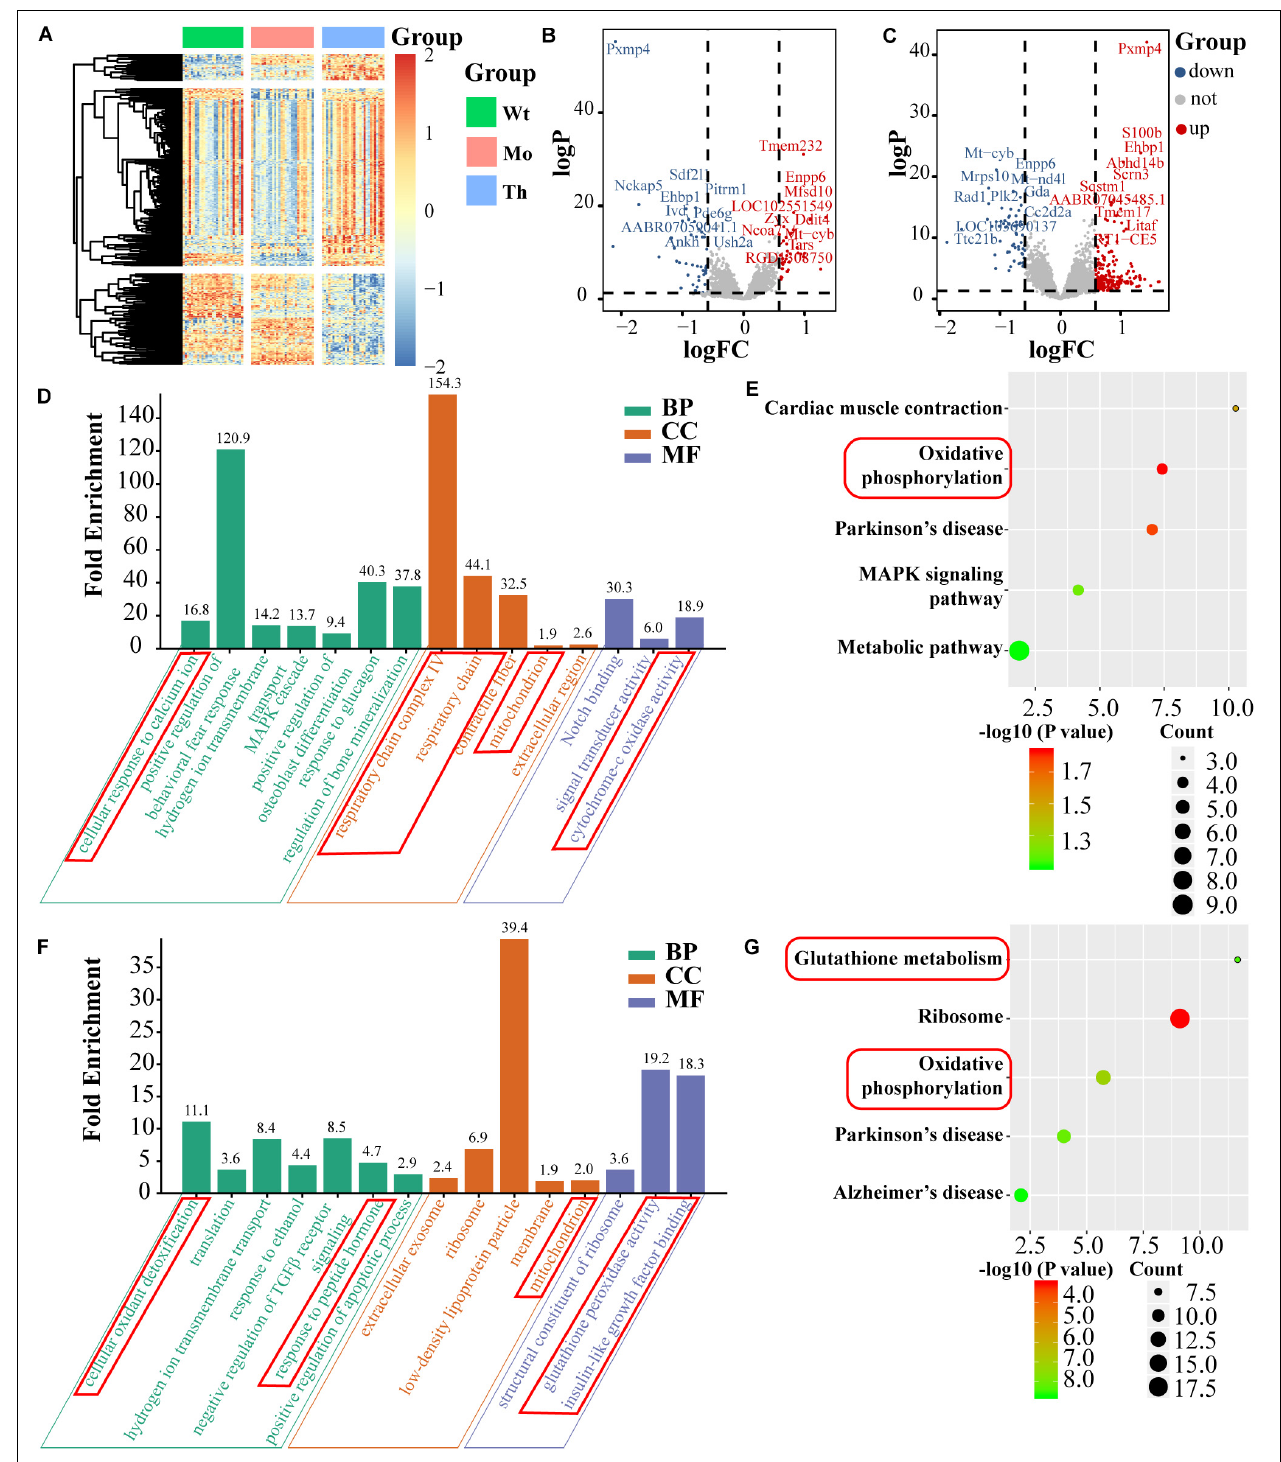
FIGURE 5 | Single-cell mRNA sequencing and bioinformatics analysis. (A) Heatmap of DEGs. (B,C) Volcano plots of DEGs (left panel for comparison between the Mo and Wt groups; right panel for comparison between the Th and Mo groups); the top 10 up-regulated and down-regulated DEGs were labeled with their names. BP, CC, and MF stand for biological process, cellular component and molecular function, respectively. (D,E) GO enrichment [(left panel), including biological process, molecular function and cellular component] and KEGG pathway (right panel) of DEGs and the core parts were marked with red frame, comparing the Mo group with Wt group. (F,G) Comparison between the Th and Mo groups as described